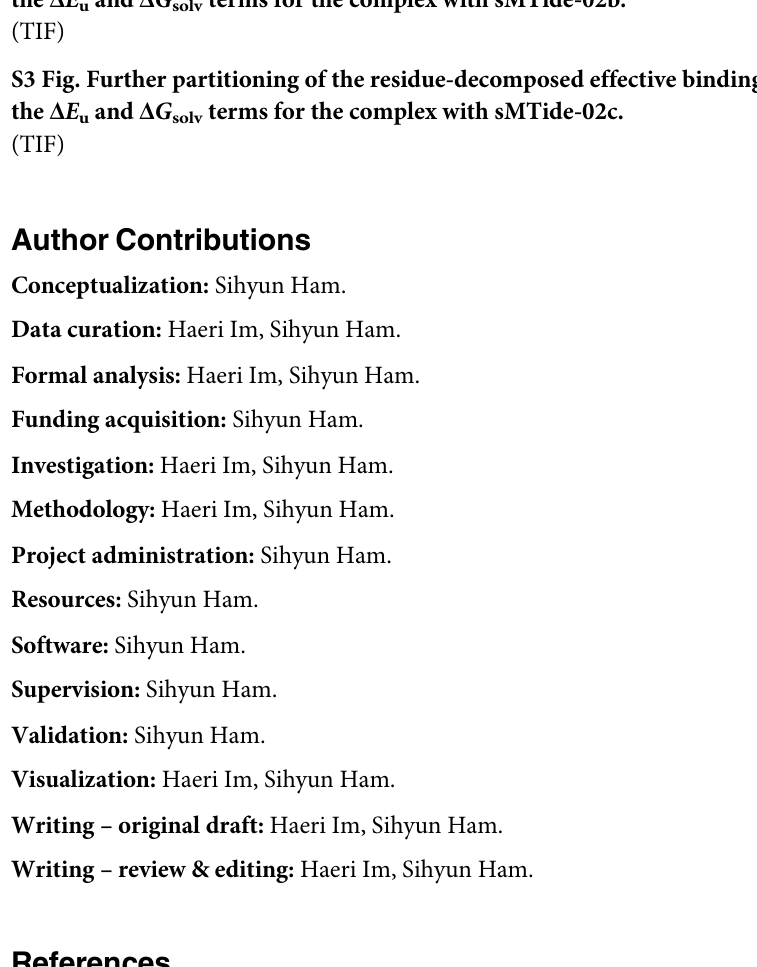
S1 Fig. Further partitioning of the residue-decomposed effective binding energy Δ f into the Δ E and Δ G terms for the complex with sMTide-02. u solv S2 Fig. Further partitioning of the residue-decomposed effective binding energy Δ f into the Δ E and Δ G terms for the complex with sMTide-02b. u solv S3 Fig. Further partitioning of the residue-decomposed effective binding energy Δ f into the Δ E and Δ G terms for the complex with u solv